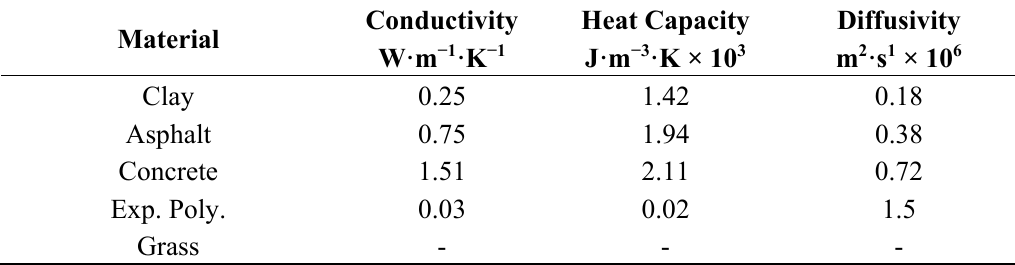
Table 3. Thermal properties of